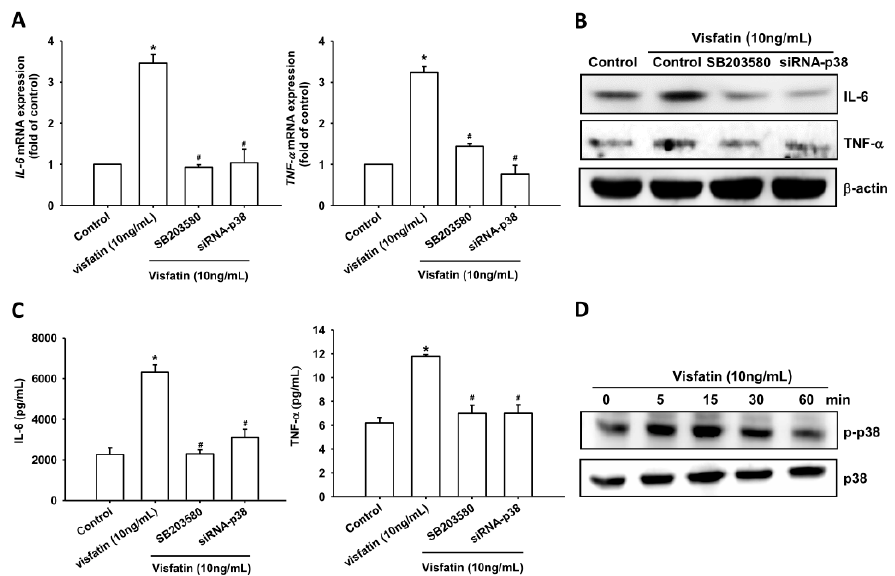
Figure 3. Visfatin induces increases in IL-6 and TNF- α expression through the p38 pathway. ( A – C ) OASFs were pretreated with SB203580 (10 μ M) for 30 min or transfected with p38 siRNA for 24 h followed by stimulation with visfatin (30 ng/mL) for 24 h; IL-6 and TNF- α expression was examined by qPCR, Western blot and ELISA assay; ( D ) OASFs were incubated with visfatin for indicated time intervals; p38 phosphorylation was examined by Western blot. Results are expressed as the mean ± S.E.M. * p < 0.05 as compared with baseline. # p < 0.05 as compared with the visfatin-treated group.